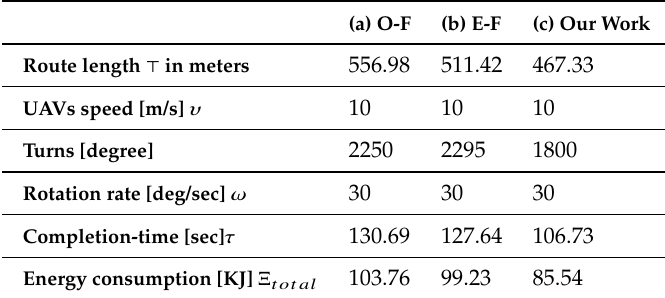
Area 2: Figure 33 represents the CPP generated in the works of [16] using O-F and E-F methods, and the obtained CPP in our